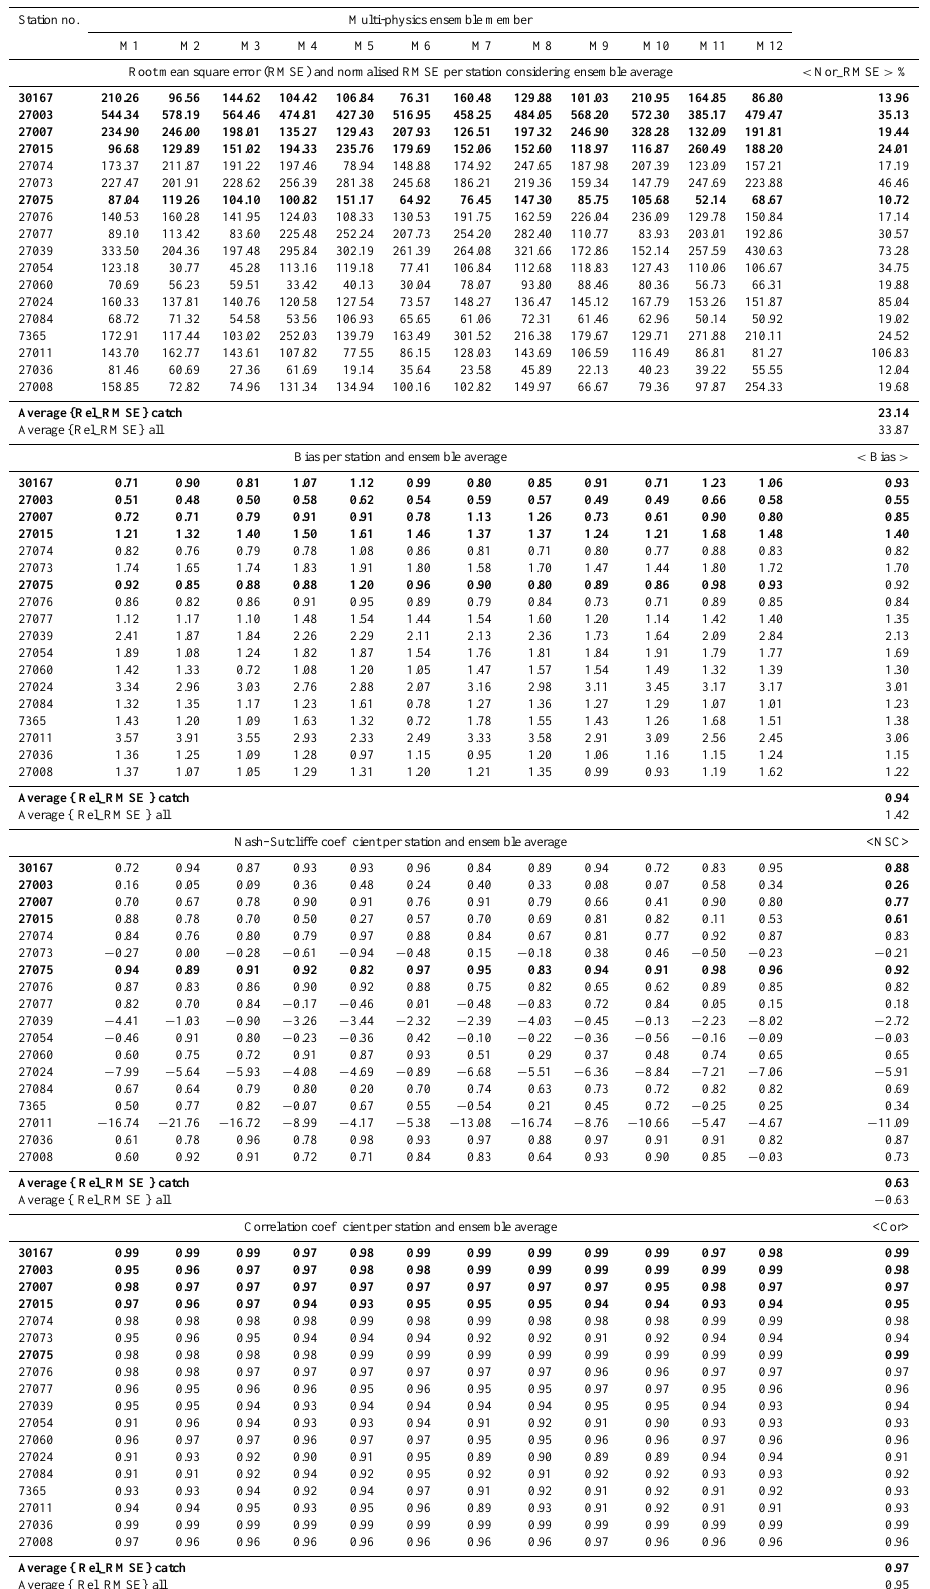
Table 2. Error metrics in the estimation of precipitation by members of the multi-physics ensemble (rows in bold indicate the stations located within the Tonalá catchment).